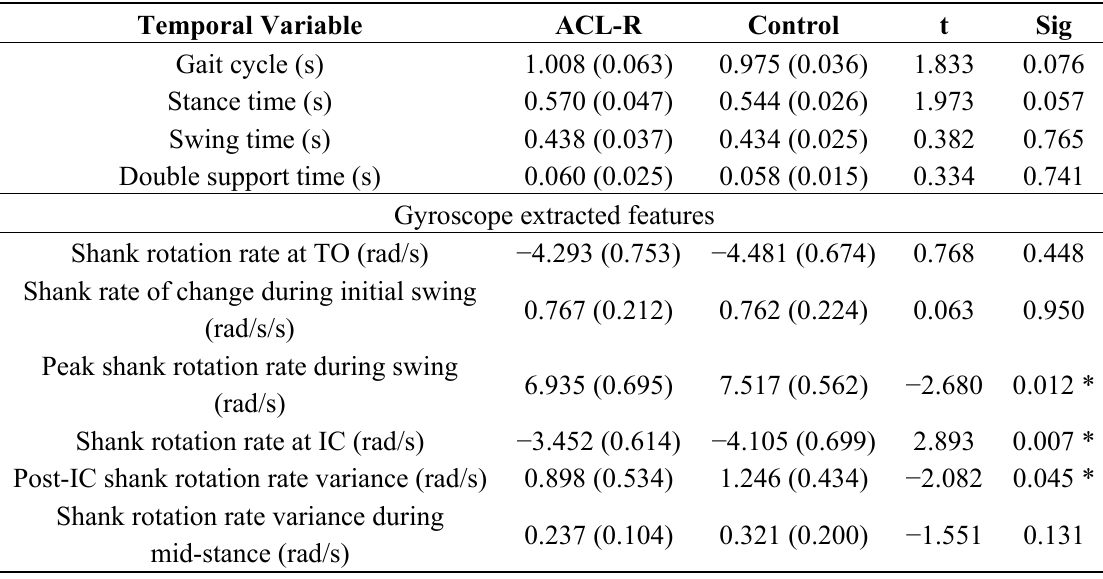
Table 2. Temporal gait parameters compared between the ACL-R and control groups. Average values are presented with standard deviations in